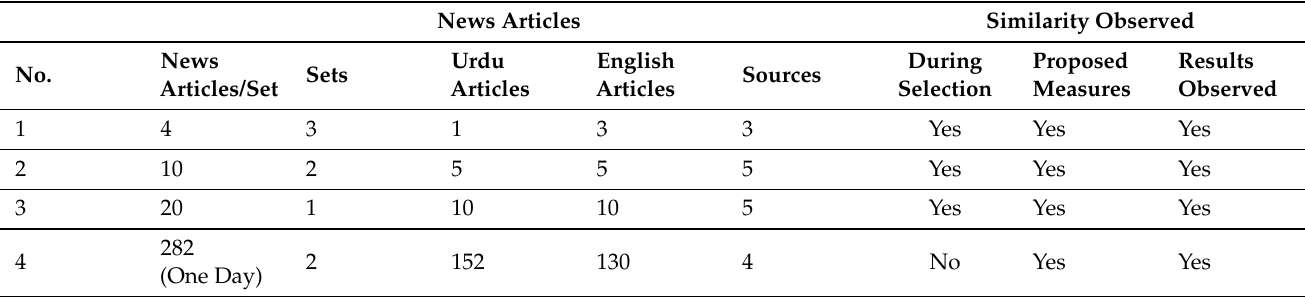
Table 3. Datasets Overview Bilingual News